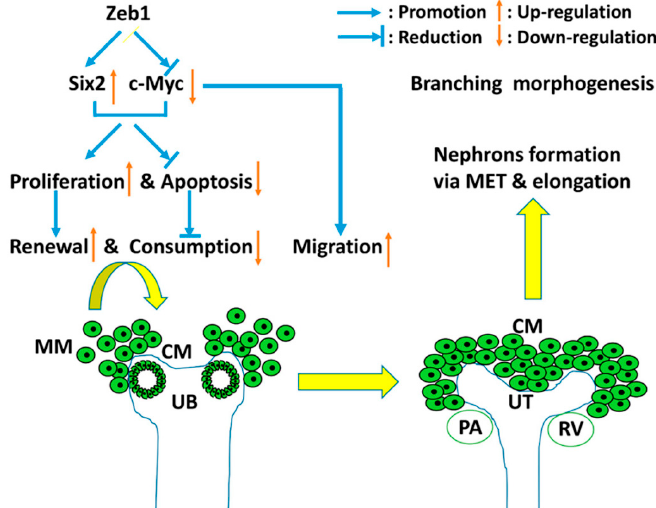
Figure 10. The work model of Zeb1 in developing embryonic kidney. Zeb1 promotes MM cell proliferation (cell renewal), cell migration but inhibits cell apoptosis (cell consumption) in association with Six2 up-regulation and c-Myc down-regulation. As the green cycles show, MM cells migrate and aggregate at UB branches with the induction of UB, then interact with UB. So the MM cell renewal, consumption and migration are essential for the induced interaction between MM cells and UB. These contributes to UB branching morphogenesis and MET and elongation for nephrons formation during embryonic kidney development.